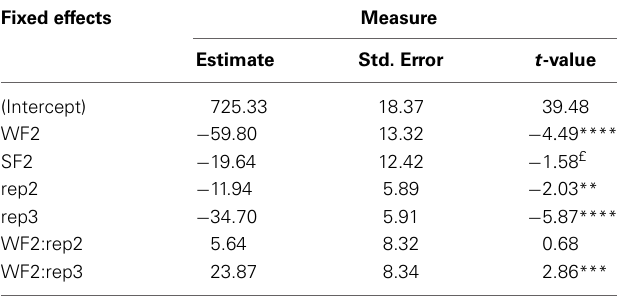
significant influences on the dependent variables (i.e., naming Table 2 | LMM estimates of fixed effects for latencies in